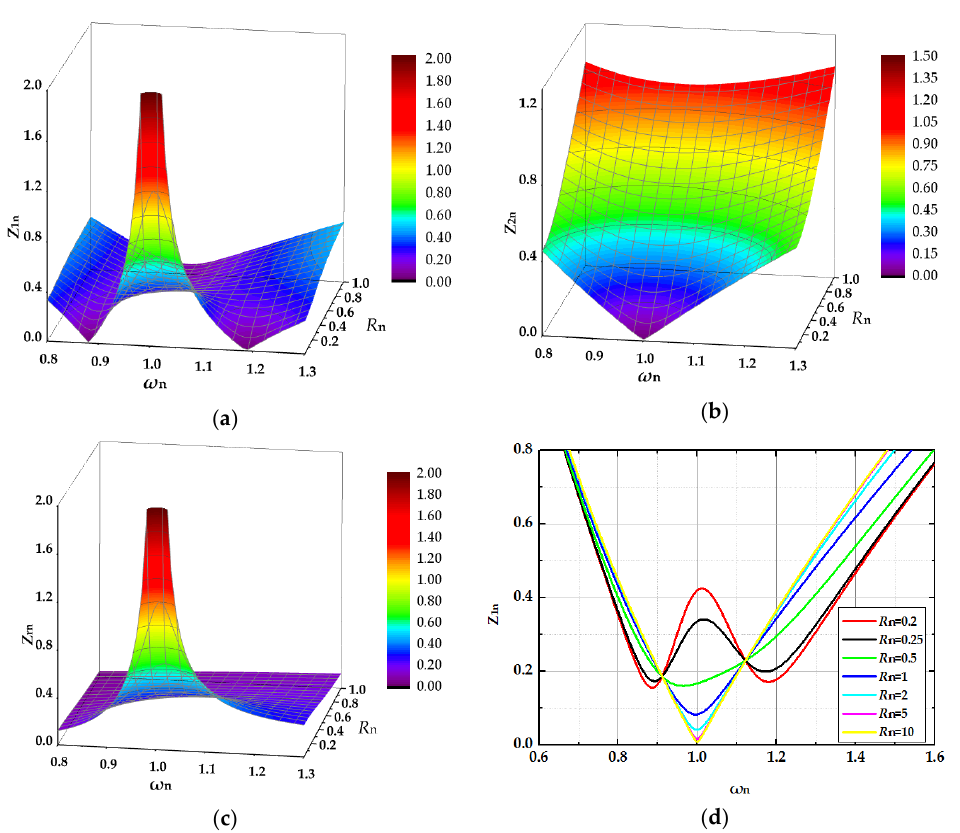
Figure 6. Plots of impedance as a function of ω n and R n at fixed k = 0.29: ( a ) The normalized primary impedance Z 1n ; ( b ) The normalized secondary impedance Z 2n ; ( c ) The normalized reflected impedance Z rn ; ( d ) The two-dimensional figure of Z 1n . Energies 2019 , 12 , x FOR PEER REVIEW